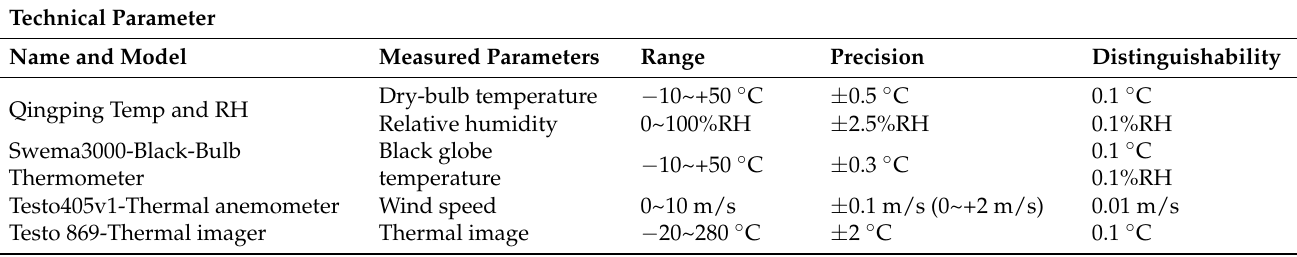
Table 2. Technical specifications of measurement and data collection